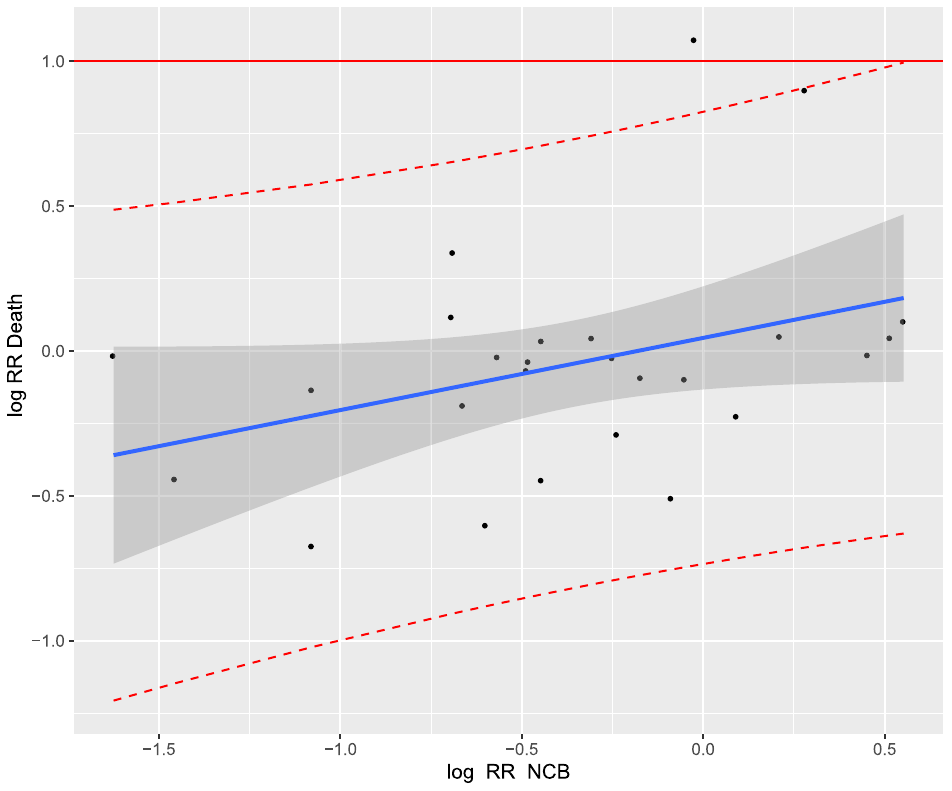
Figure 5. Trial-level association between treatment effects on net clinical benefit (NCB) and all-cause mortality in the treatment of the prevention of VTE in medical patients. Cor = 0.32 and the linear regression model was "Log RR Death = 0.26 × Log RR NCB + 0.05”. Each study is represented by a circle. A log scale was used for the x-axis and y-axis. The solid blue line represents the regression line and the grey area represents the 95% confidence interval. The red dashed lines represent the upper and lower limits of the 95% prediction interval. RR, relative